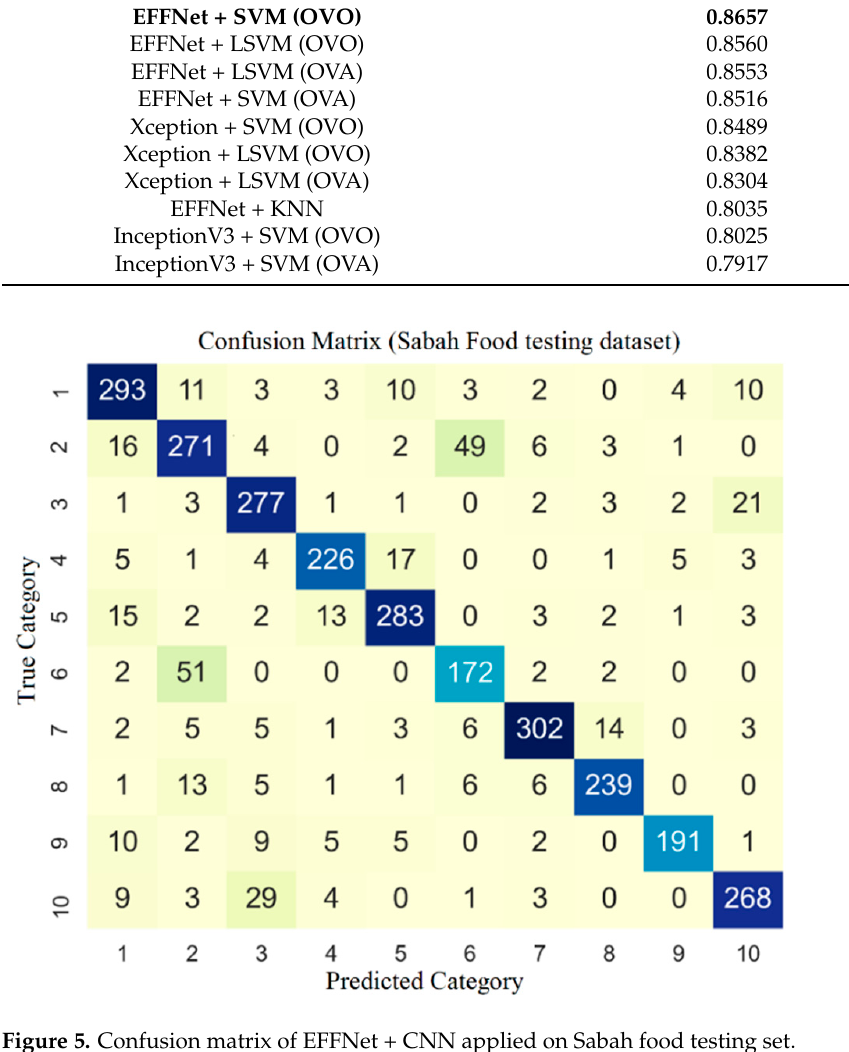
Table 17. The ten highest performing machine-learning approaches for VIREO-Food172 Dataset.